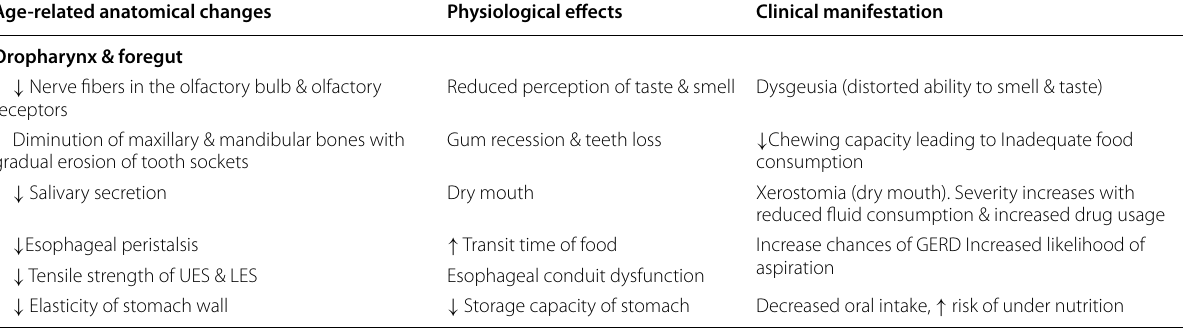
Table 1 Age related anatomical & physiological changes and their clinical manifestations Age-related anatomical changes